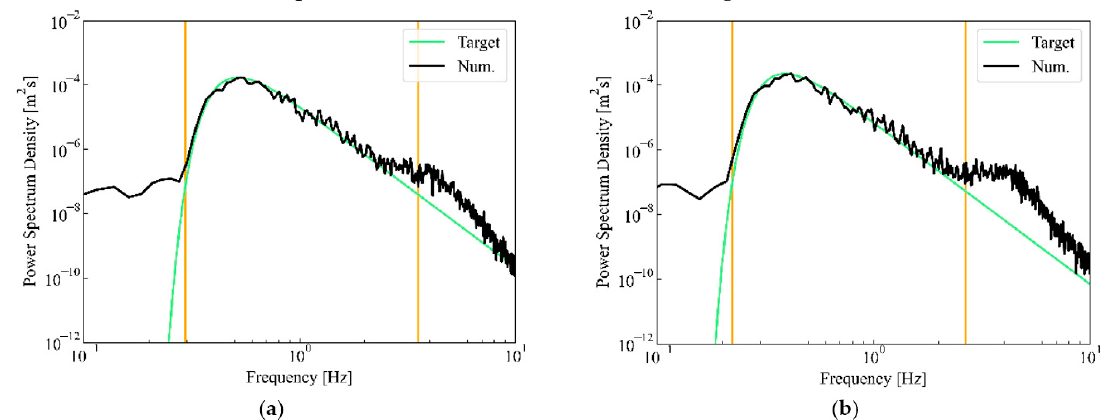
Figure 19 Figure 19. Power spectrum density of the water surface fluctuations at x = 0 and y = 0 in the absence of the caisson: ( a ) f s = 0.59 Hz; ( b ) f s = 0.44 Hz.